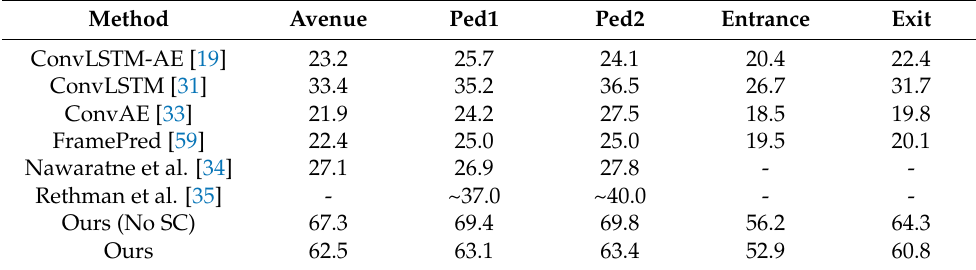
Table 4. Comparison of existing methods on the processing speed (FPS). (No SC: indicates the removal of spatial